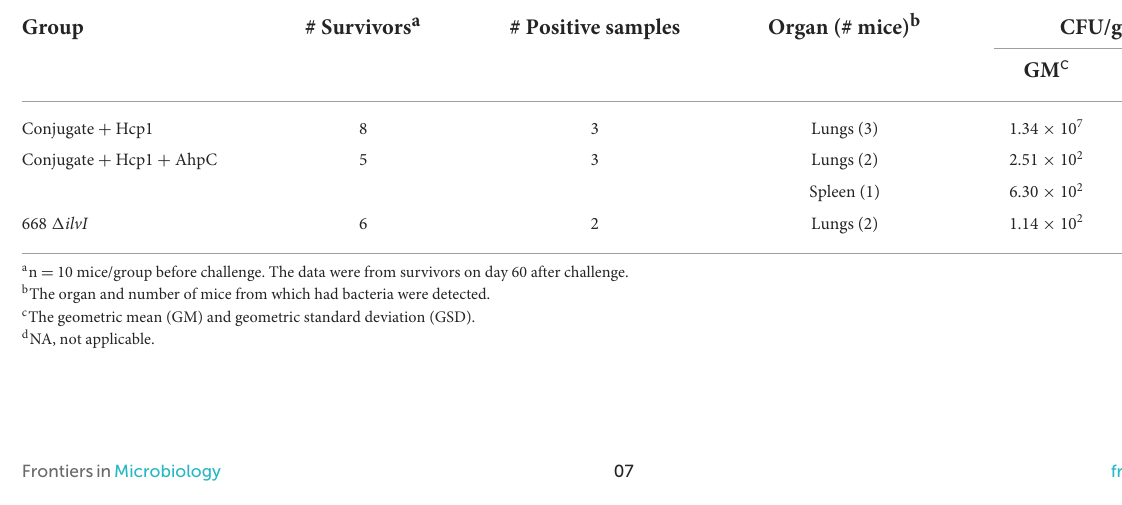
TABLE 1 Detection of bacteria in mice surviving challenge with B. pseudomallei . Group